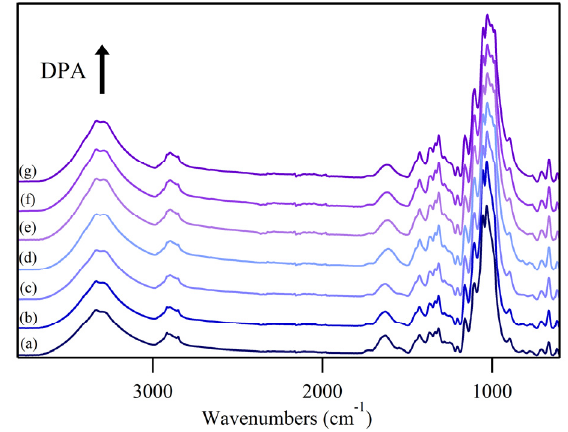
Figure 1. FTIR spectra of cotton fibers harvested at different DPA: (a) 18 days post-anthesis (DPA); (b) 20 DPA; (c) 24 DPA; (d) 28 DPA; (e) 32 DPA; (f) 36 DPA; and (g) 40 DPA. Spectra are shown shifted along the